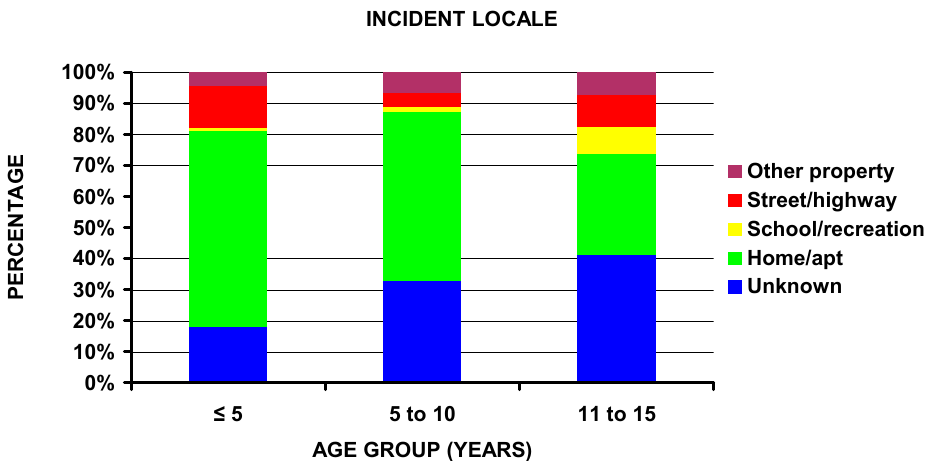
Figure 5. Di ff erences by disposition from the ED: ( a ) by race ( p = 0.011); ( b ) by perpetrator of the injury ( p = 0.0006); ( c ) by intent of the injury ( p < 10 − 4 ); ( d ) by year time span ( p = 0.004).